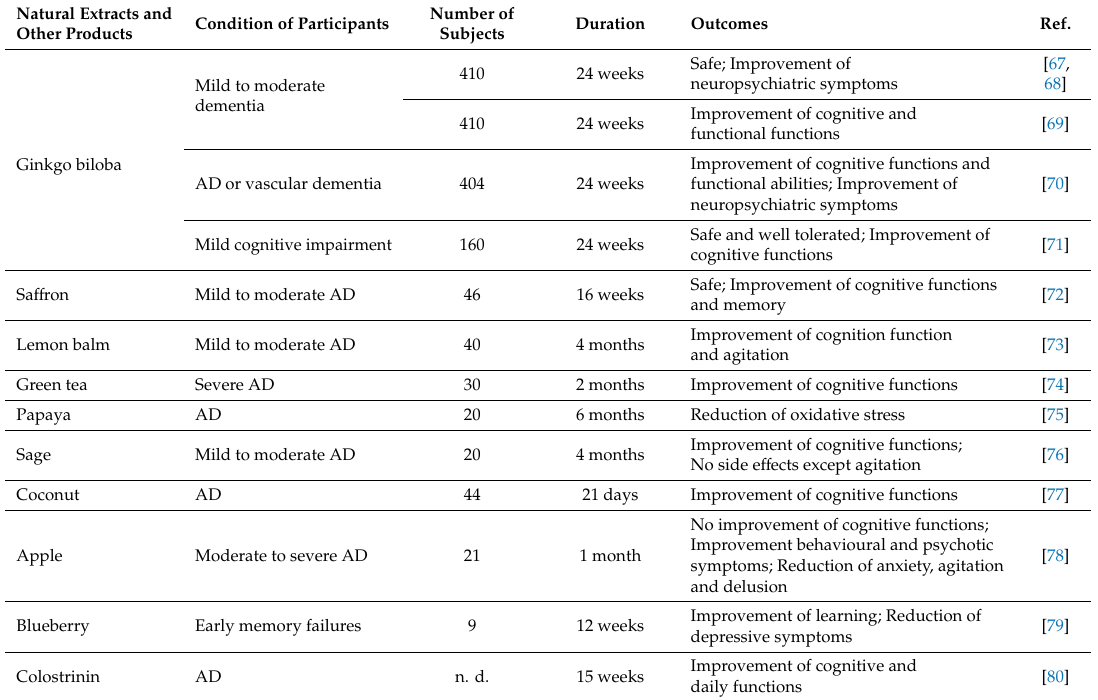
Table 2. Natural extracts and other natural products in clinical trials for AD